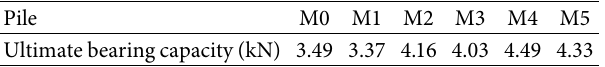
Figure 7: Q-s curve. Table 5: The ultimate bearing capacity of the model